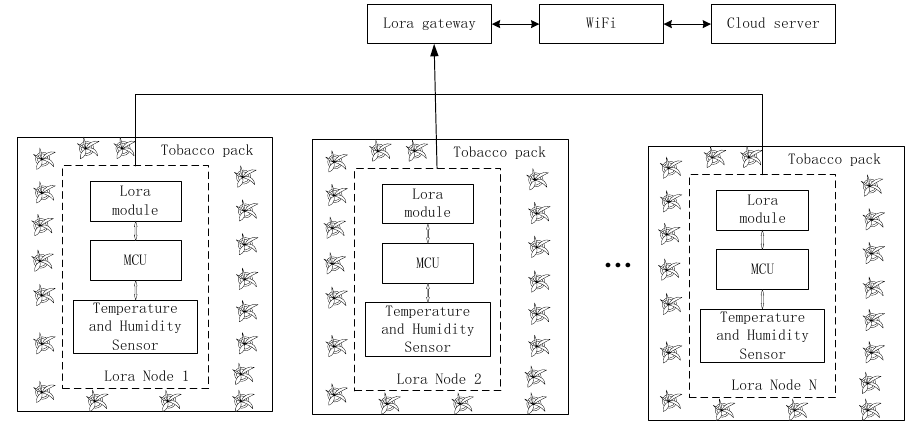
Fig. 1. The structure of the system .